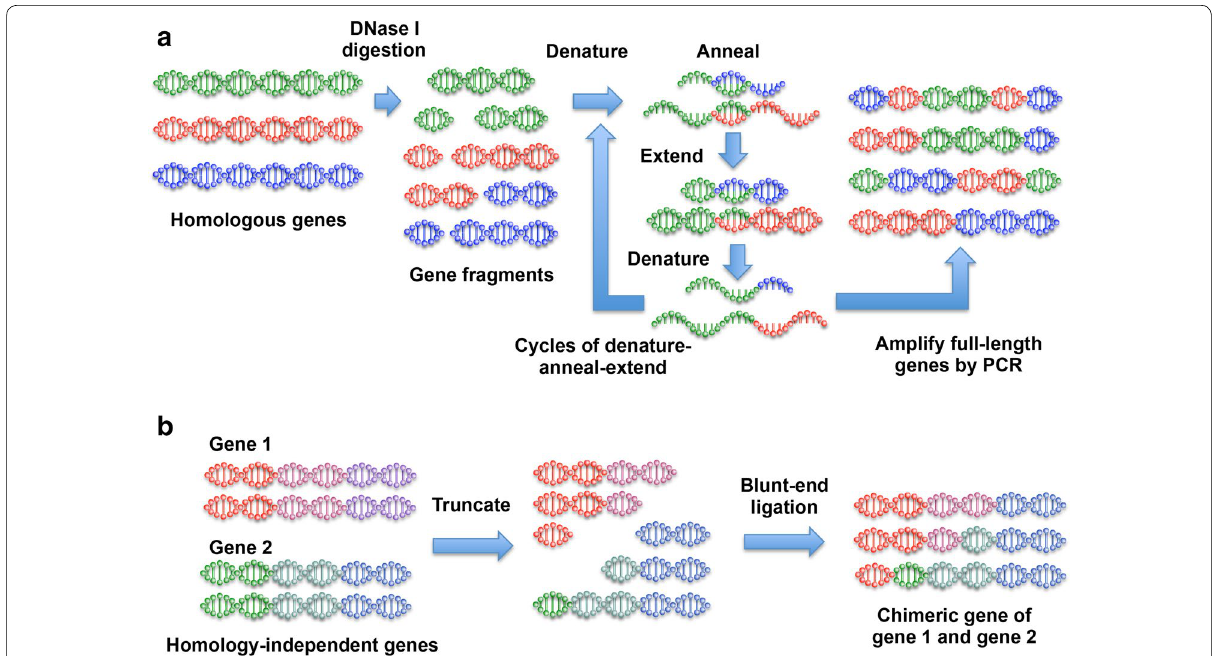
Fig. 16 Illustrations of genetic recombination methods for protein evolution. a DNA shuffling (in vitro recombination of homologous genes). b ITCHY (in vitro recombination of homology-independent genes) (Figure adapted from Ref.